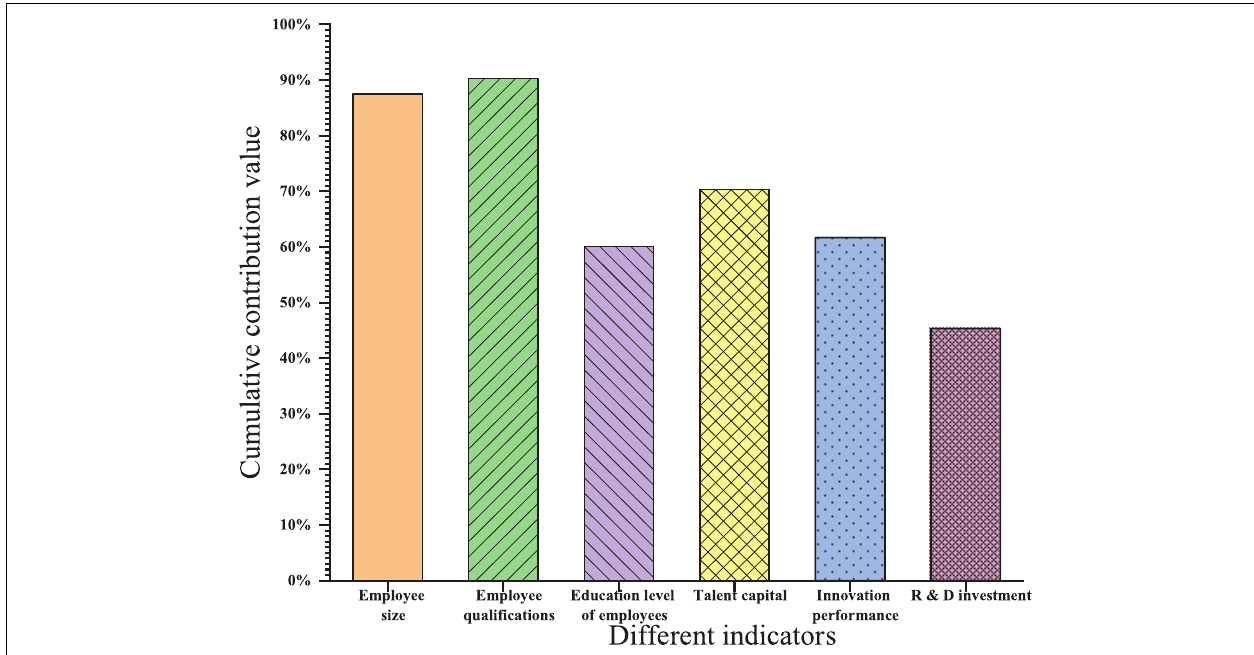
FIGURE 5 | Cumulative contribution value of variance in the first-level indicator.